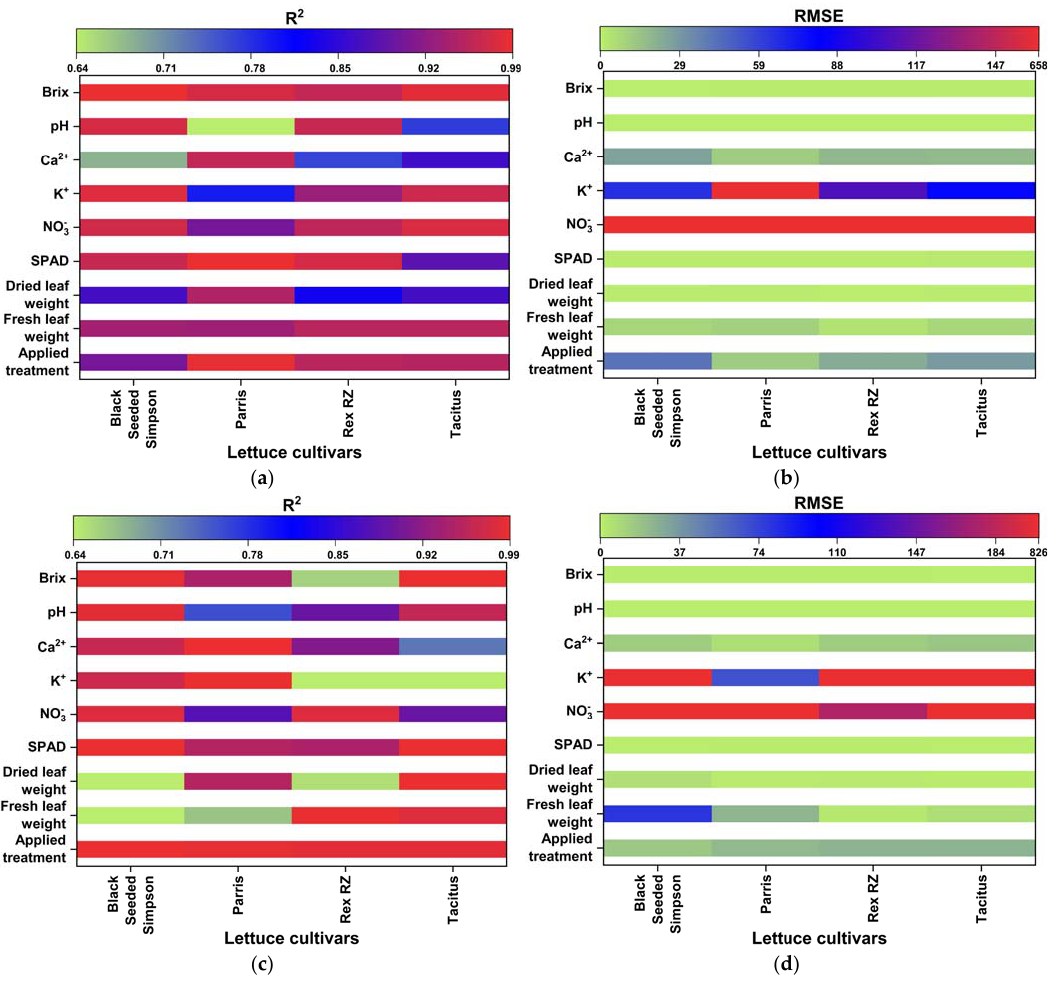
Figure 8. R 2 and RMSE values of the investigated parameters of different lettuce cultivars grown in hydroponics ( a , b ) and in the NFT system ( c , d ). Table 5. Fitted model accuracy (R 2 , RMSE) of models using waveband indices found from FDR, PLSR/PCA, and VIP score of PLSR/PCA for hydroponically grown lettuce cultivars.